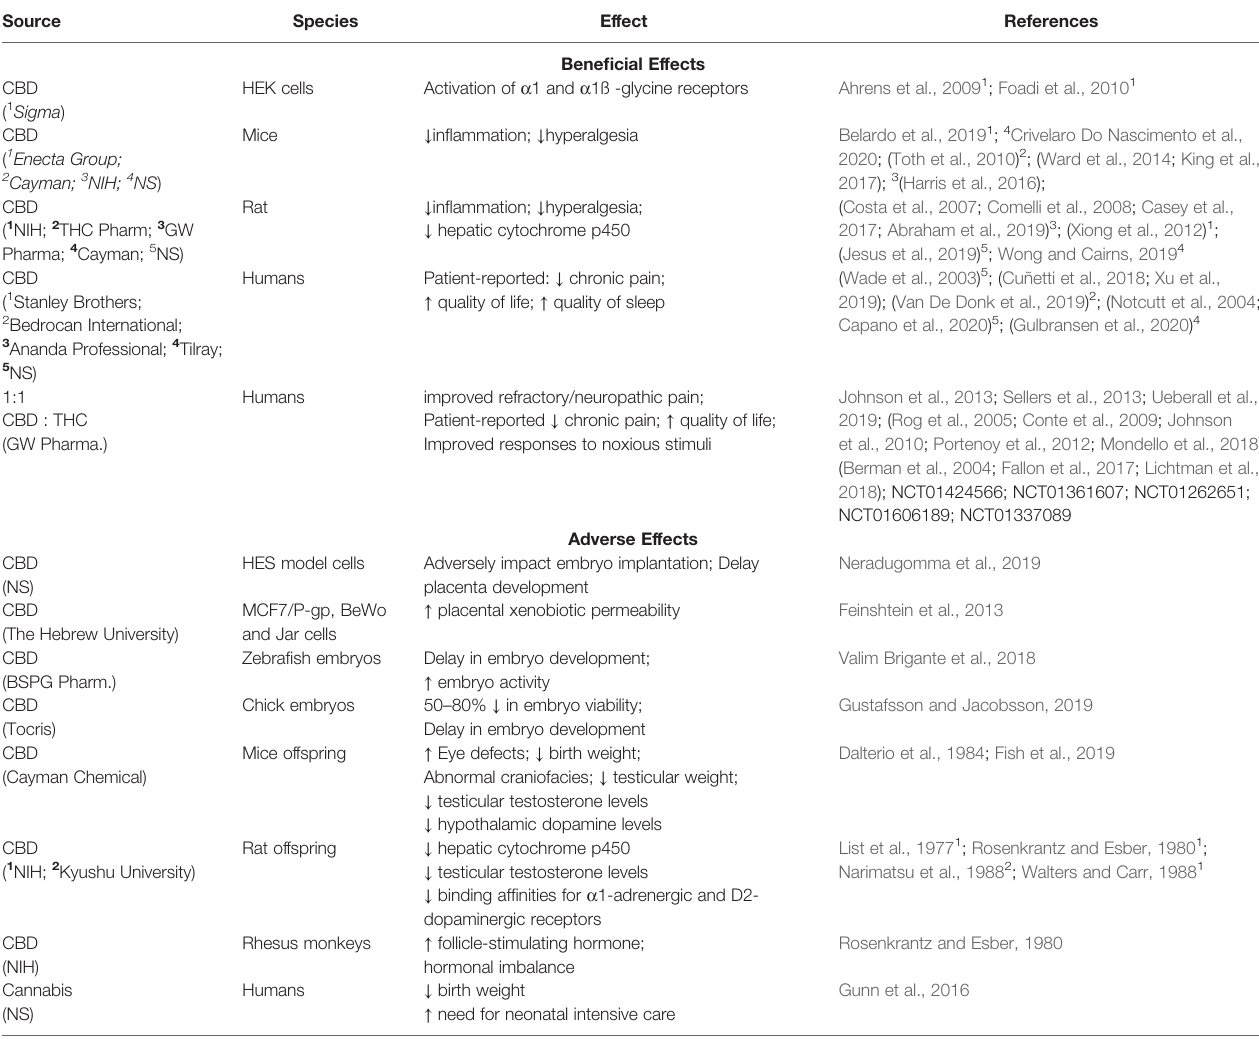
TABLE 1 | Consequence of Cannabidiol treatment in preclinical and clinical